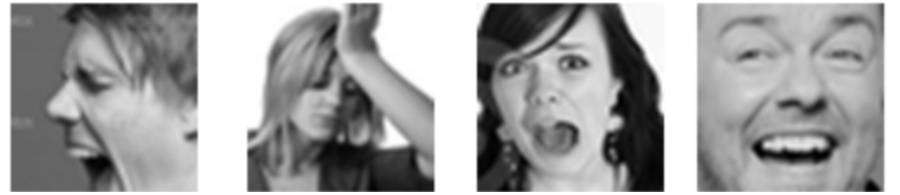
Figure 4. Four sample images from the FER